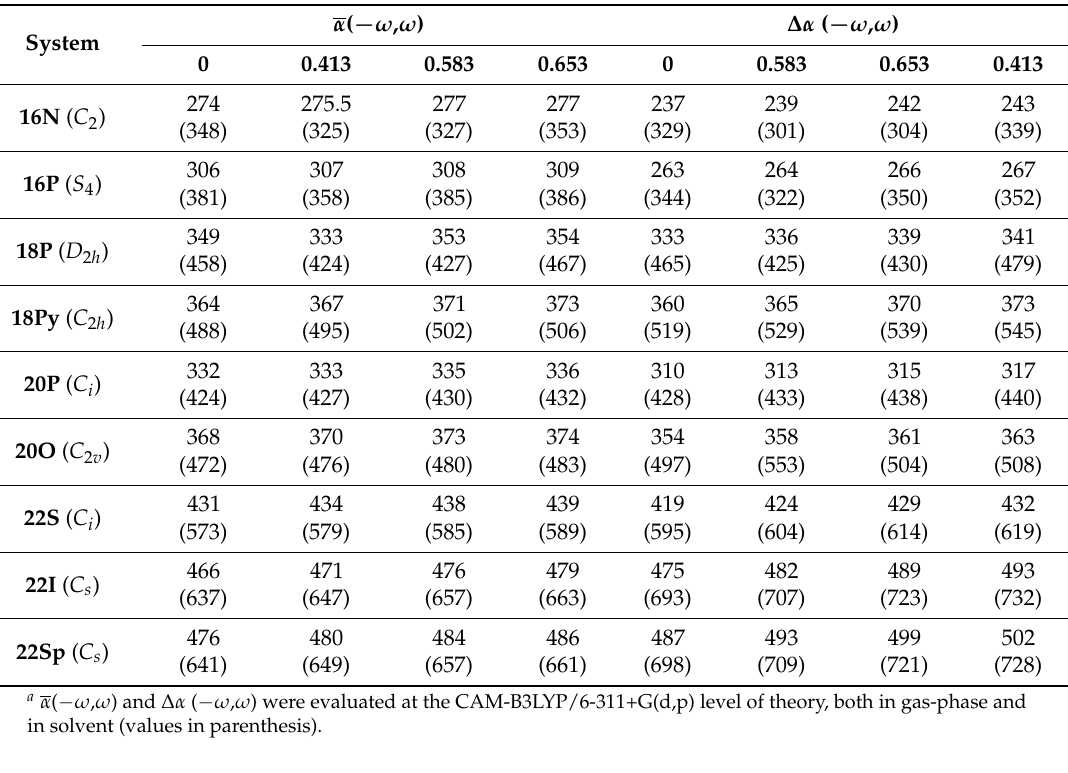
Table 7. Average polarizability α and ∆ α (in a.u.) of unsubstituted Hückel porphyrinoids computed at different frequencies ( ω in eV) a .